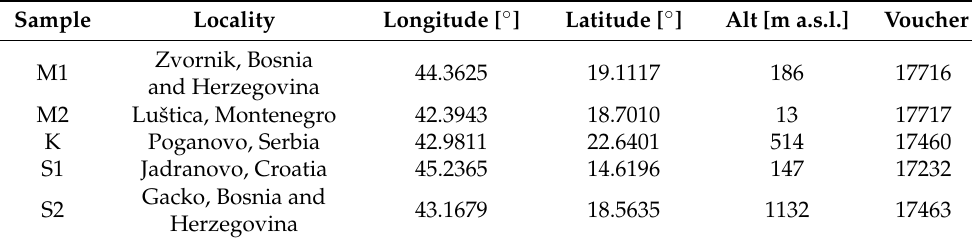
Table 4. Geographic and geologic characteristics of sampling sites for S. montana , S. subspicata, and S. kitaibelii